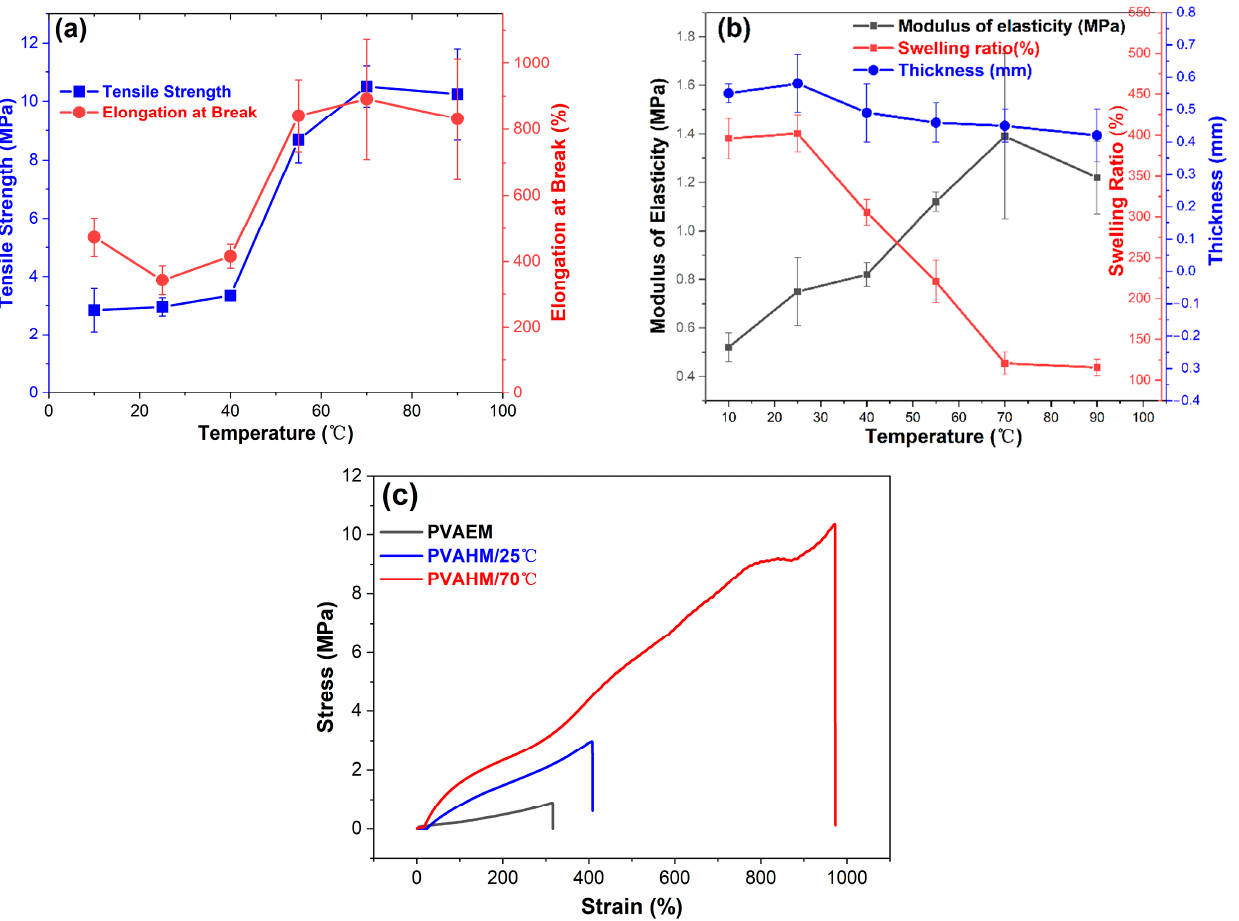
Figure 2. ( a , b ) The effects of temperature on the physicomechanical properties of PVAHMs ( n = 5) and ( c ) the stress–strain curves of PVAEM prepared at 25 °C and PVAHMs prepared at 25 °C and 70 °C (the PVA hydrogel film was prepared from 5 mL of 10% PVA aqueous solution; strips of 30 mm × 5 mm in the dry state were used after rehydration as testing samples at 45% RH; average thickness of the strips ~0.55 mm).